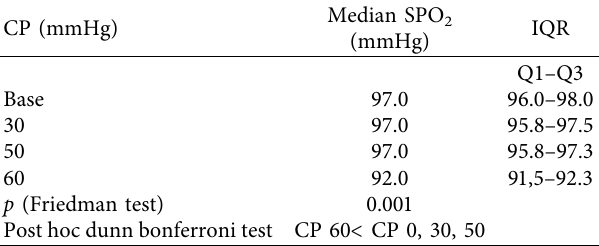
Table 4: Variation of SpO 2 measurements in ICP pressure